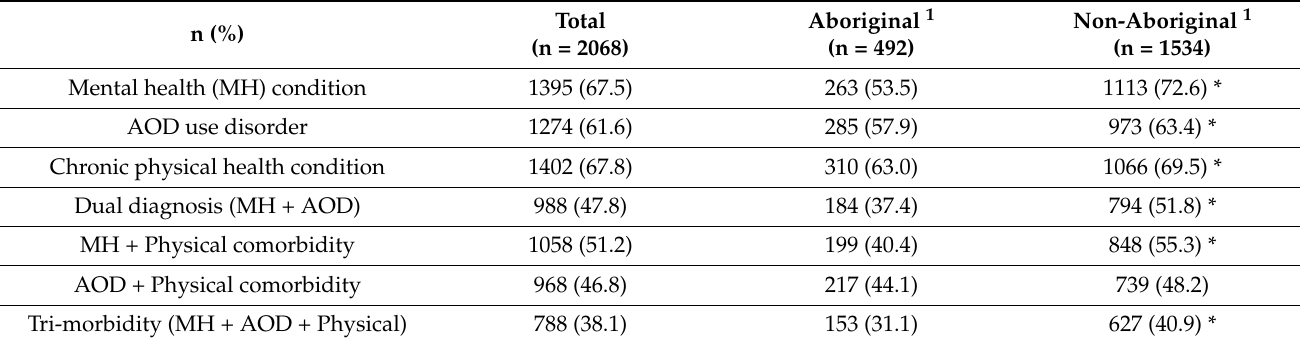
Table 5. Dual Diagnosis and Tri-Morbidity Among Homeless Healthcare Patients.